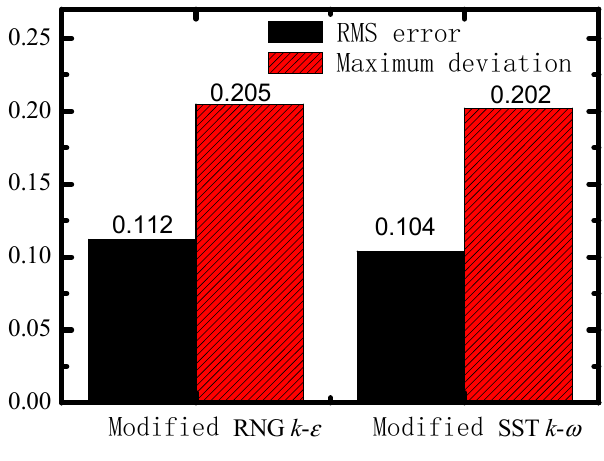
Figure 10. Error analysis at 50 ° С .